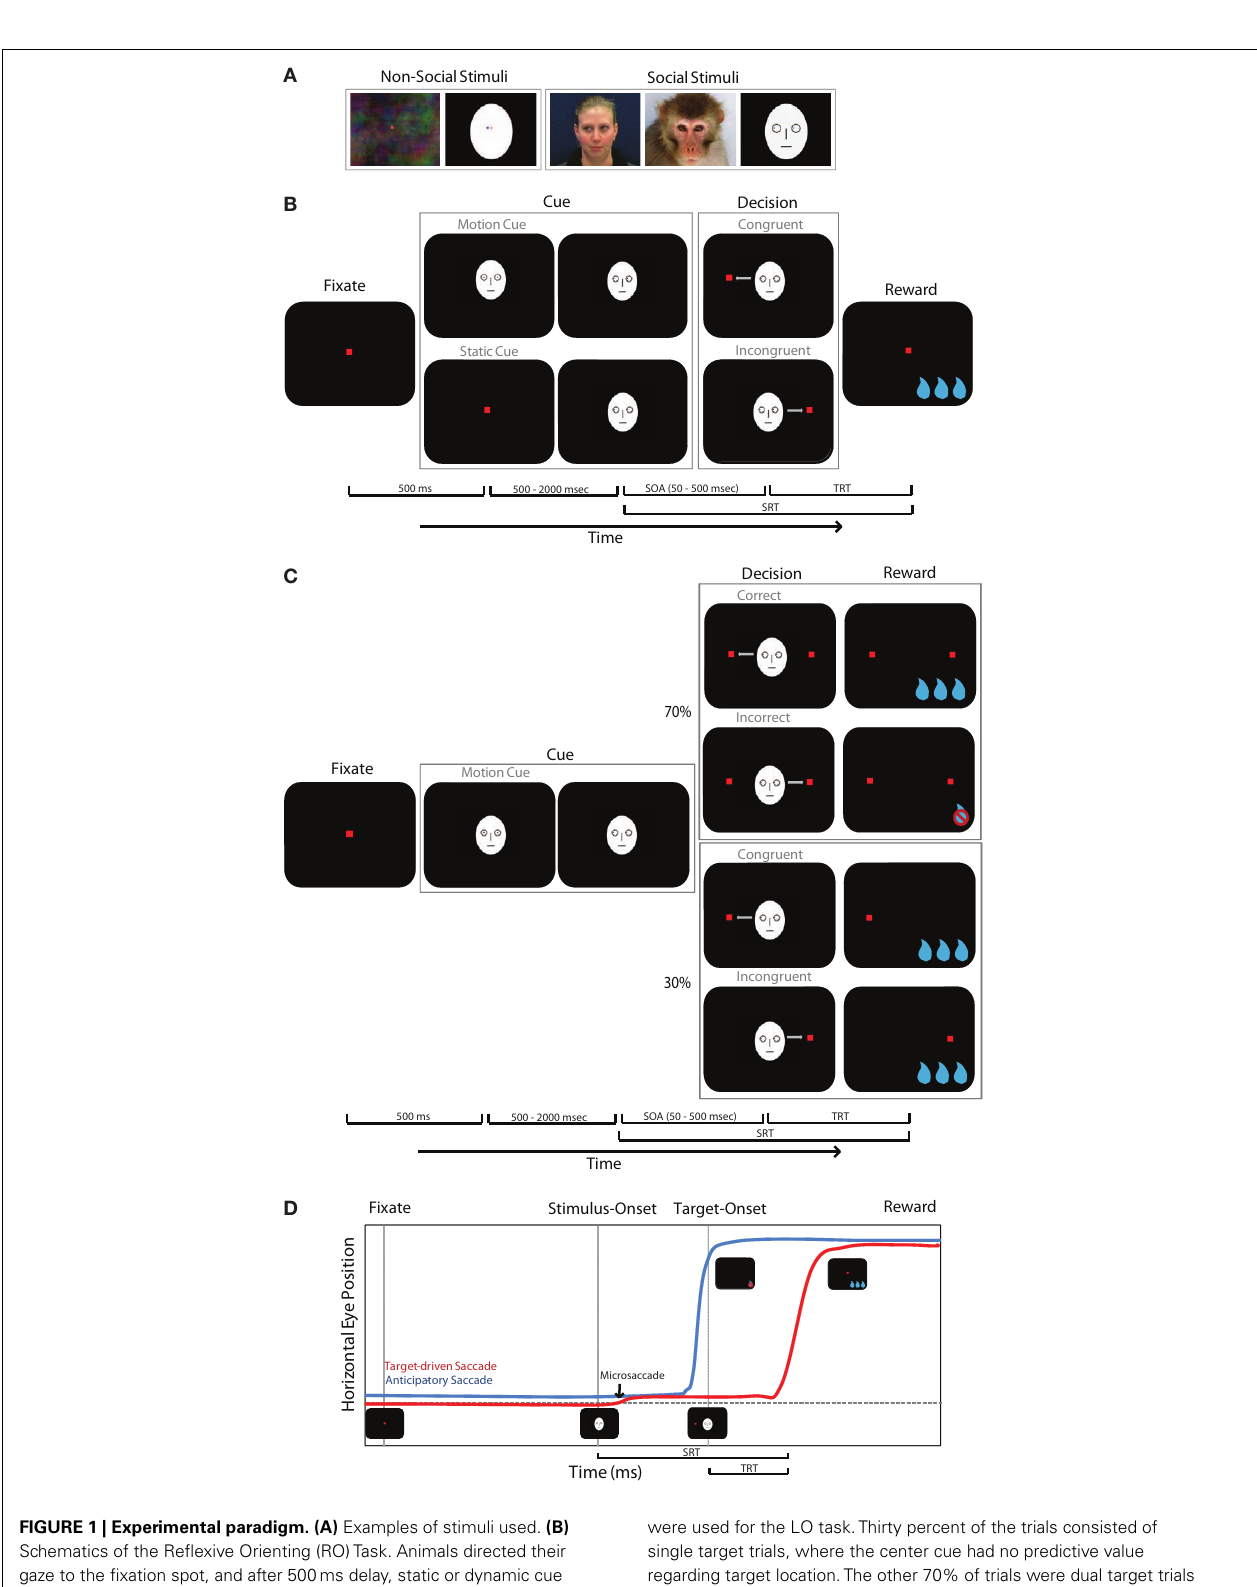
FIGURE 1 | Experimental paradigm. (A) Examples of stimuli used. (B) Schematics of the Reflexive Orienting (RO)Task. Animals directed their gaze to the fixation spot, and after 500ms delay, static or dynamic cue stimuli were shown at random. After a variable SOA, a peripheral target appeared either on the cued or un-cued one side of the stimulus. Animals made saccades to the target to receive reward. (C) Schematics of the Learned Orienting (RO)Task. Only dynamic cues